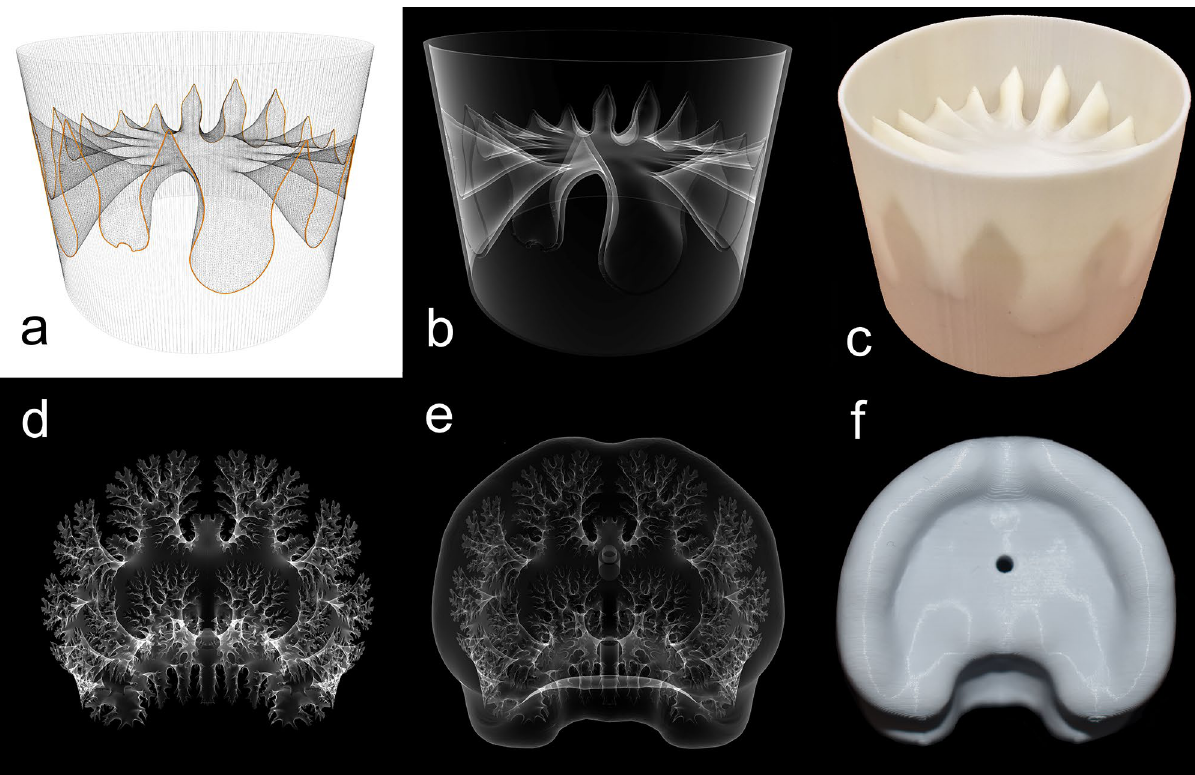
Figure 2. Creation of cylindrical shells models ( a – c ) and chamber models ( d – f ) used in liquid retention experiments. ( a ) Wireframe view showing the suture (orange) wrapped around the internal whorl section. ( b ) Extruded, virtual model with the cylindrical shell and septum unified together. ( c ) Final 3D printed model used to measure the liquid retained by surface tension in the septal recesses. ( d ) Virtual model of a single chamber (camera). ( e ) Virtual model of the camera subtracted from a bounding volume. ( f ) Final, 3D printed model with empty chamber inside and holes for drainage on the adoral, adapical, and ventral sides of the